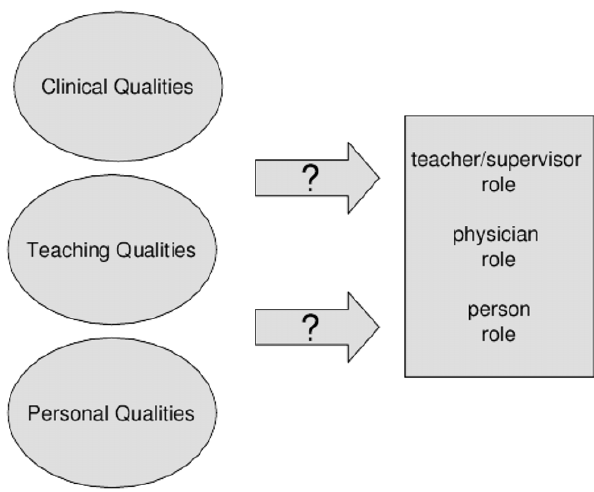
Figure 1. Relationship between role model characteristics and the role model typologies.